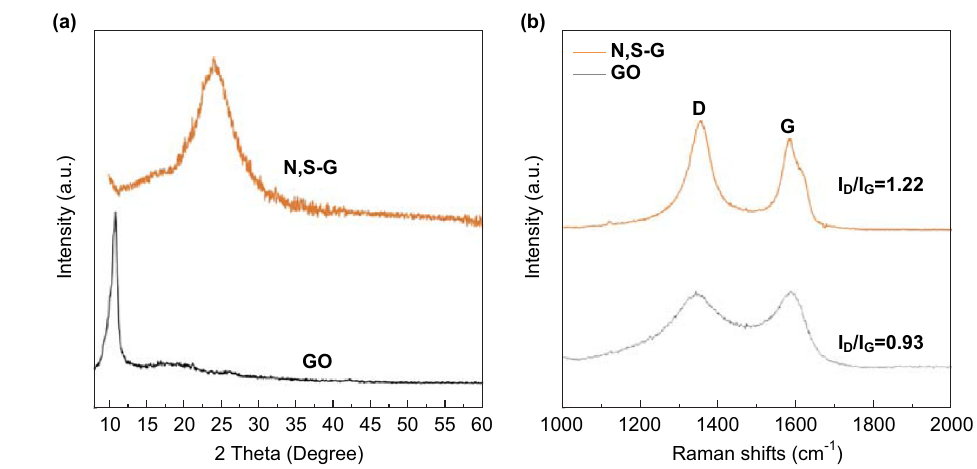
Fig. 2 a XRD patterns of GO and N,S-G. b Raman spectra of GO and N,S-G